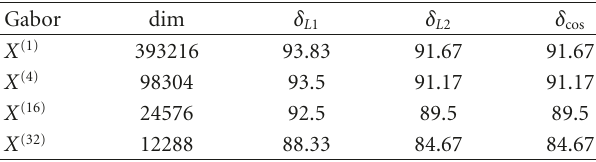
Table 3: Face recognition performance for Gabor wavelets with di ff erent downsampling factors using FERET database and three di ff erent similarity measures: L 1 distance measure, δ L 1 , L 2 distance measure, δ L 2 and cosine similarity measure, δ cos